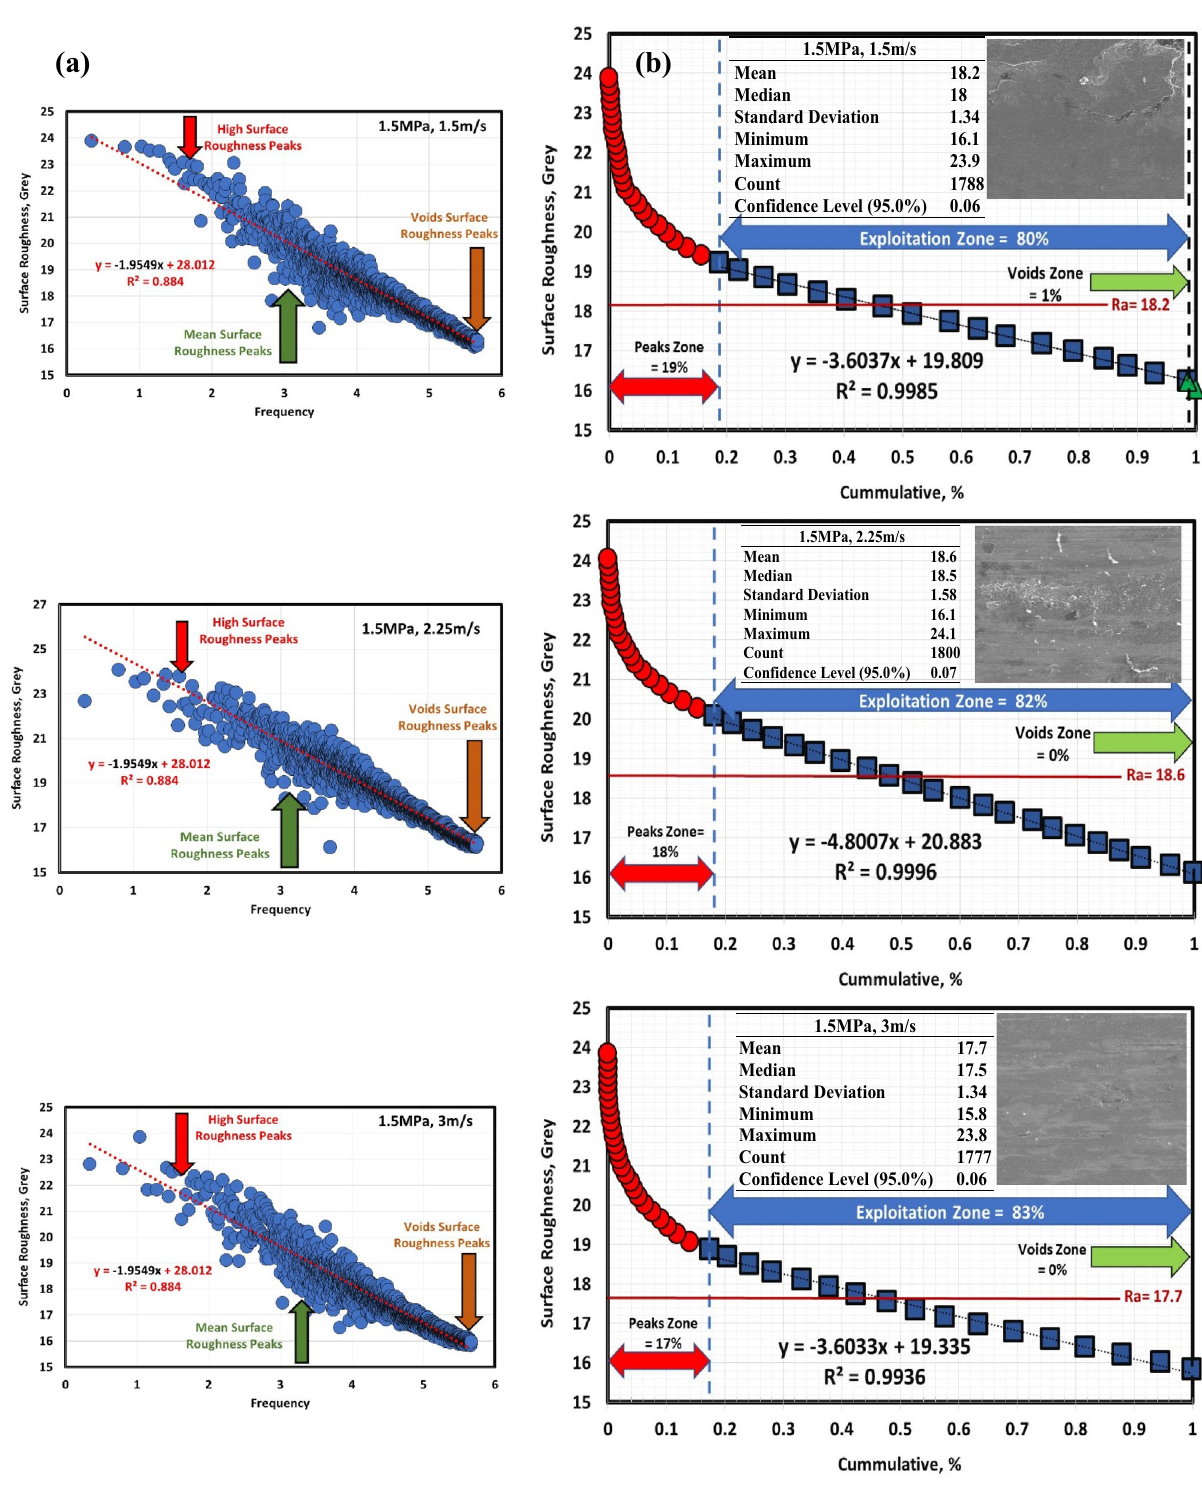
Figure 7. ( a ) Surface texture and& ( b ) Abbott Firestone curves at 1.5 MPa and different velocities of